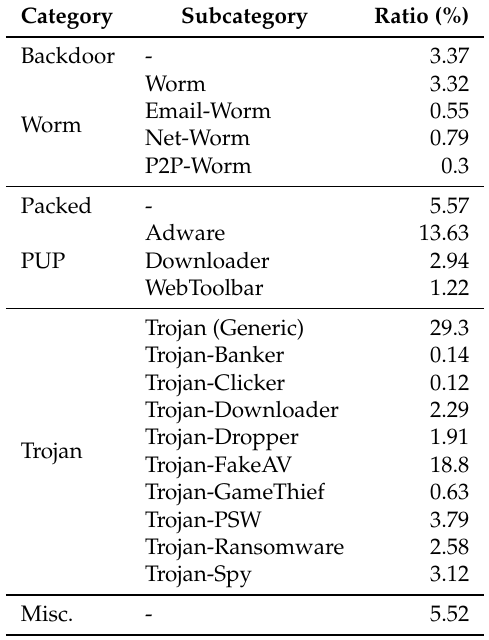
Table 6. API-based malware detection system dataset description. Excerpt from [37].